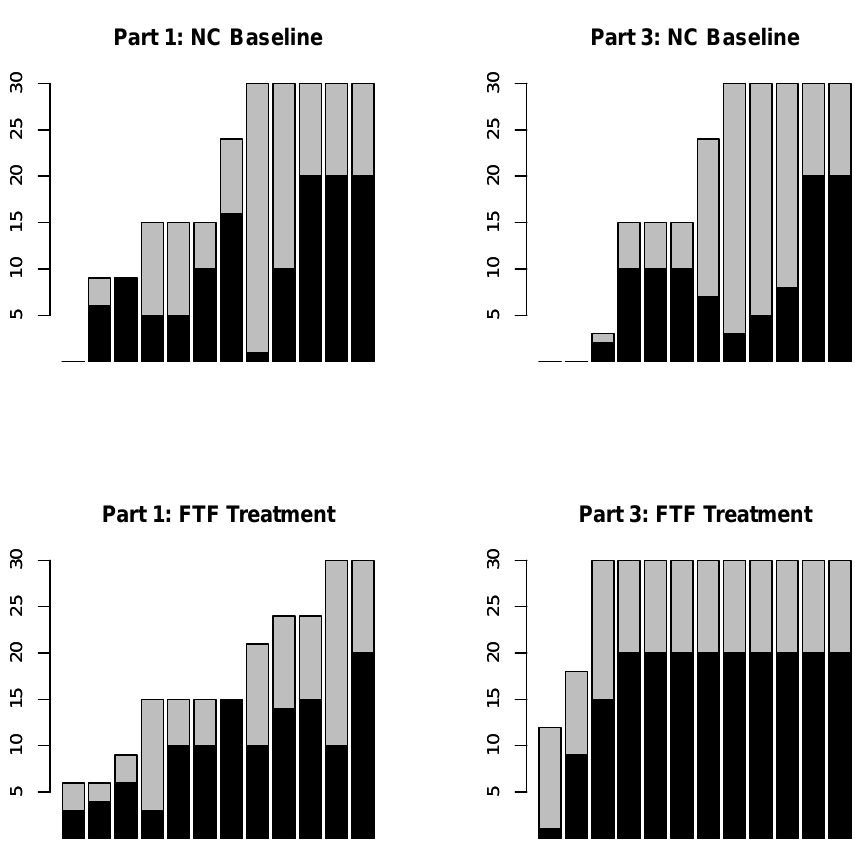
Figure 1. No Communication (NC) and Face-to-Face communication (FTF): amount sent tripled (grey) and amount returned (black), by